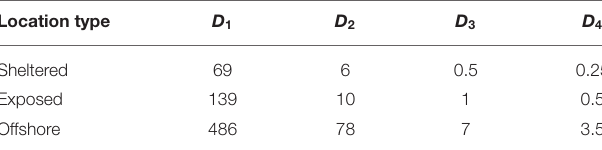
TABLE 3 | Estimated time until settlement (h) of the four POM compartments released from the three sites. Location type D 1 D 2 D